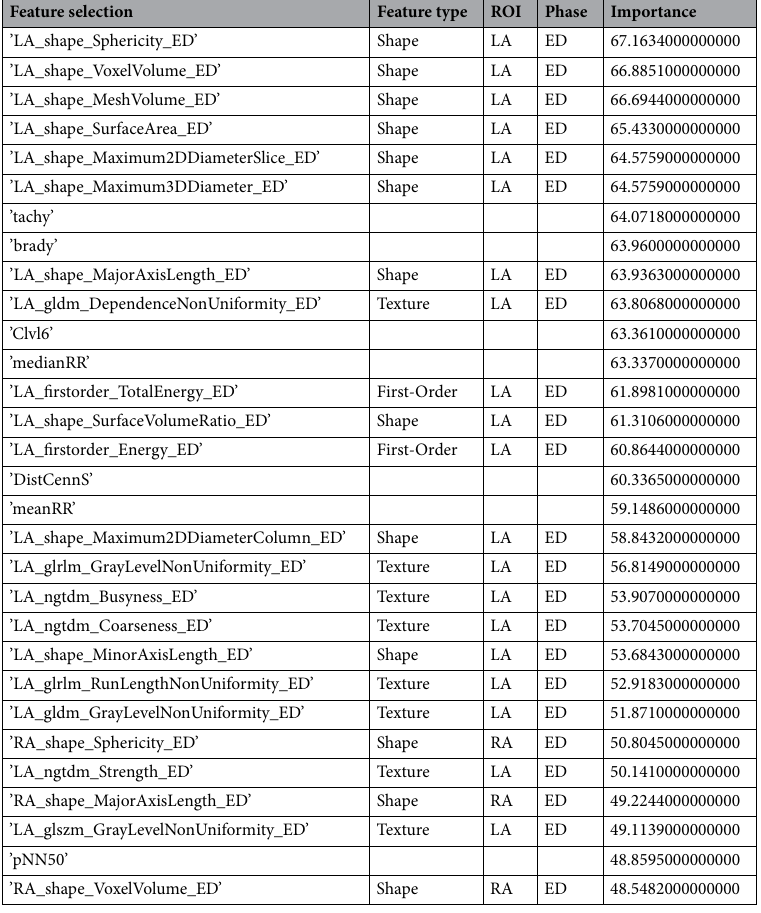
Table 4. Feature selection for AF for men for the electro-radiomics